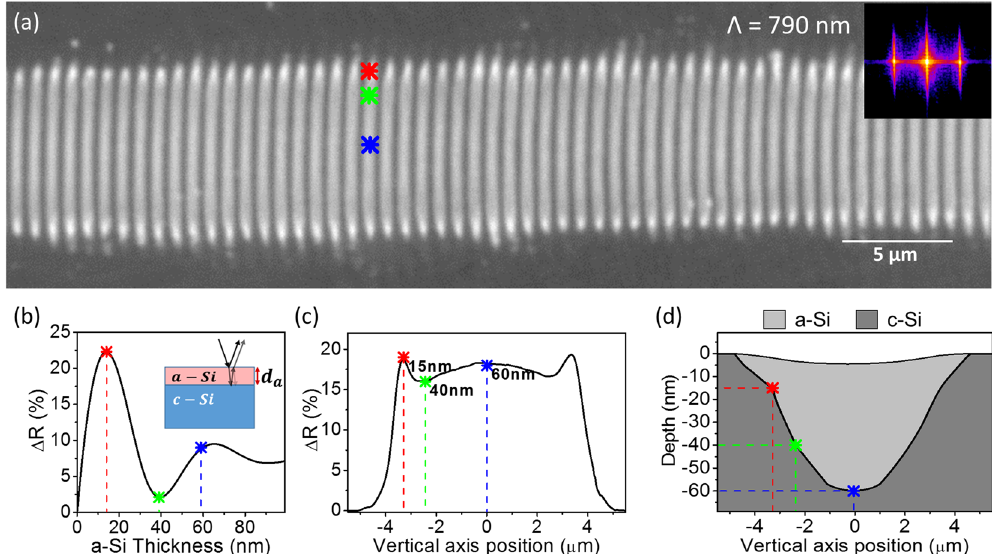
Figure 2. ( a ) Optical micrograph of extended amorphous-crystalline fringes in Si after irradiating the sample with horizontally polarized laser pulses at 100 Hz moving the sample at constant speed v = 200 μ m/s, using F = 190 mJ / cm 2 . Inset: Two-dimensional Fourier transform of ( a ). The first order corresponds to the value of the period Λ indicated. ( b ) Calculated reflectivity change as a function of thickness of an amorphous top layer, as indicated in the inset and using the model described in the text. The inflection points of the curve are marked by star symbols. ( c ) Experimental vertical profiles of ( c ) the reflectivity change and ( d ) the surface topography (top curve in ( d )) of a single fringe shown in ( a ). The lower curve in ( d ), indicating the thickness of the amorphous layer has been extracted from ( b ) and ( c ), effectively displaying the cross section of an amorphous fringe (shaded